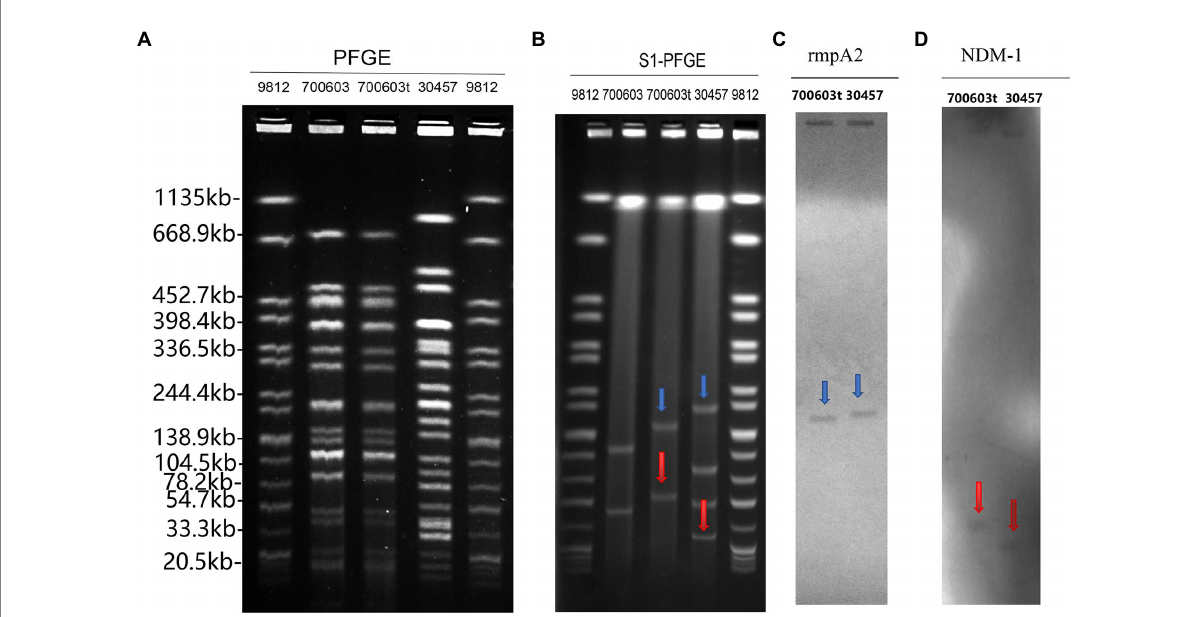
FIGURE 7 PFGE, S1 -PFGE and Southern hybridization analysis of 700,603 transformant strain (A) PFGE, Clonal relatedness was established using XbaI -PFGE. (B) S1 -PFGE: S1 nuclease digestion of genomic DNA of K. pneumoniae strains was followed by PFGE. Plasmid bands are shown as linearized fragments on the gel. (C) Southern blot hybridization of the marker gene (rmpA2) of the virulence plasmid, marked with a blue arrow. (D) Southern blot hybridization of bla